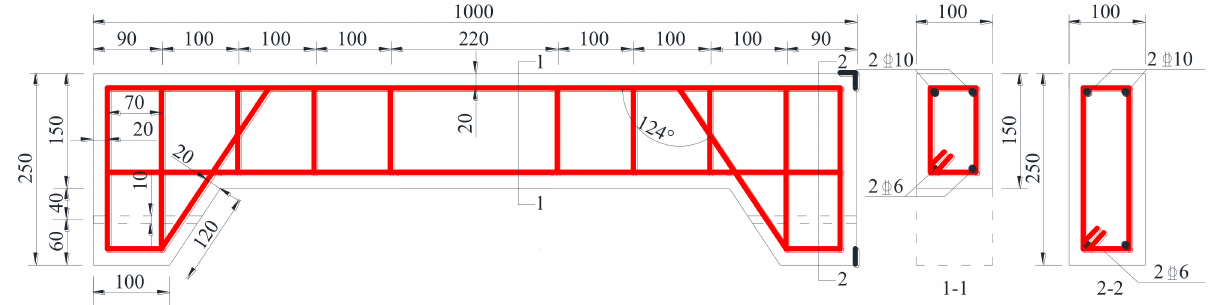
Figure 3. Schematic diagram of test beam member (unit: